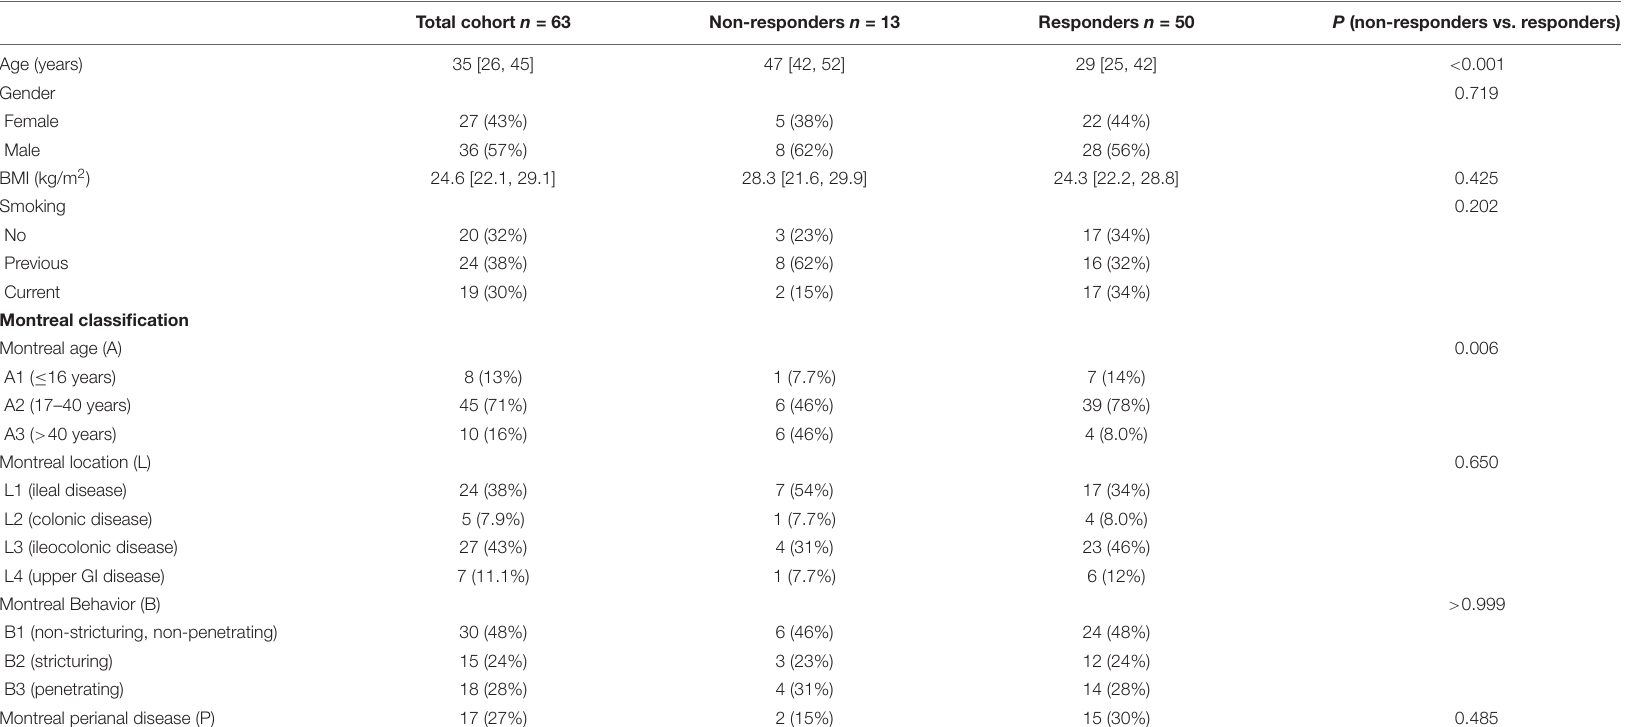
TABLE 2 | Baseline demographics and clinical characteristics of the study